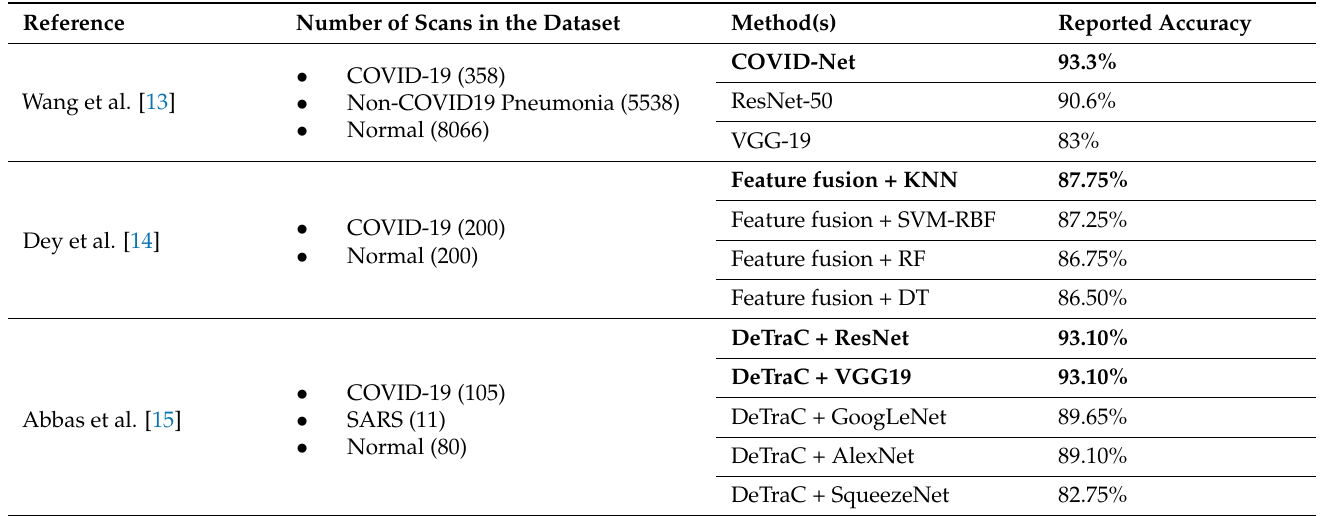
Table 1. A survey of latest proposed deep learning techniques in detecting